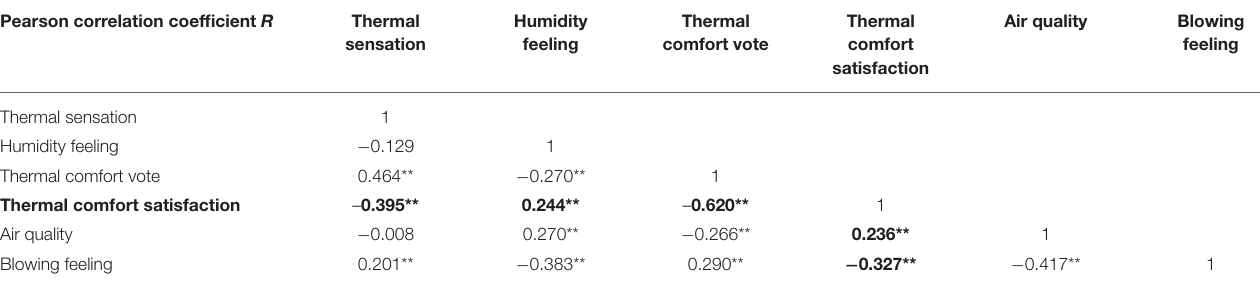
TABLE 6 | Correlation analysis of variables in summer.